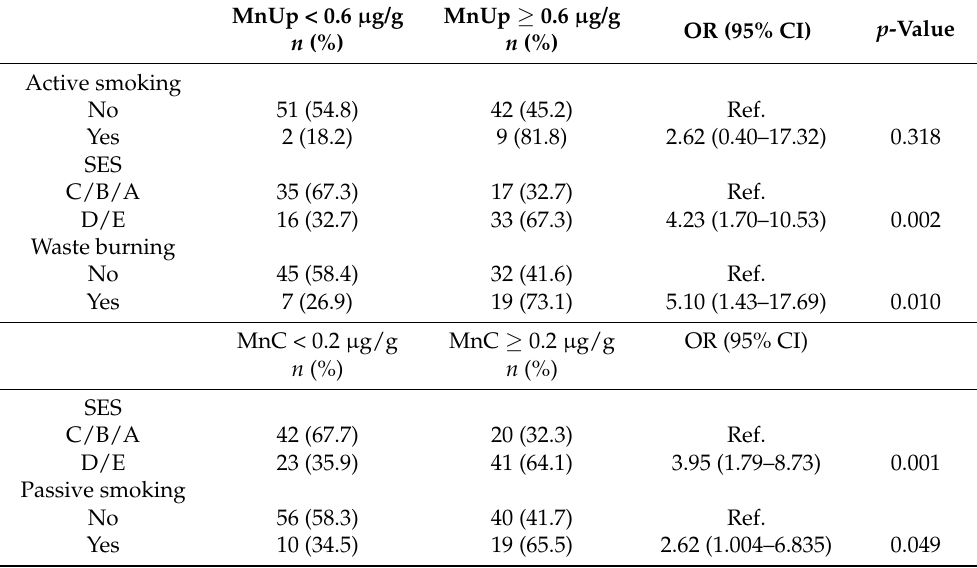
Table 5. Determinants of Mn biomarker levels above the median after χ 2 test and MLR